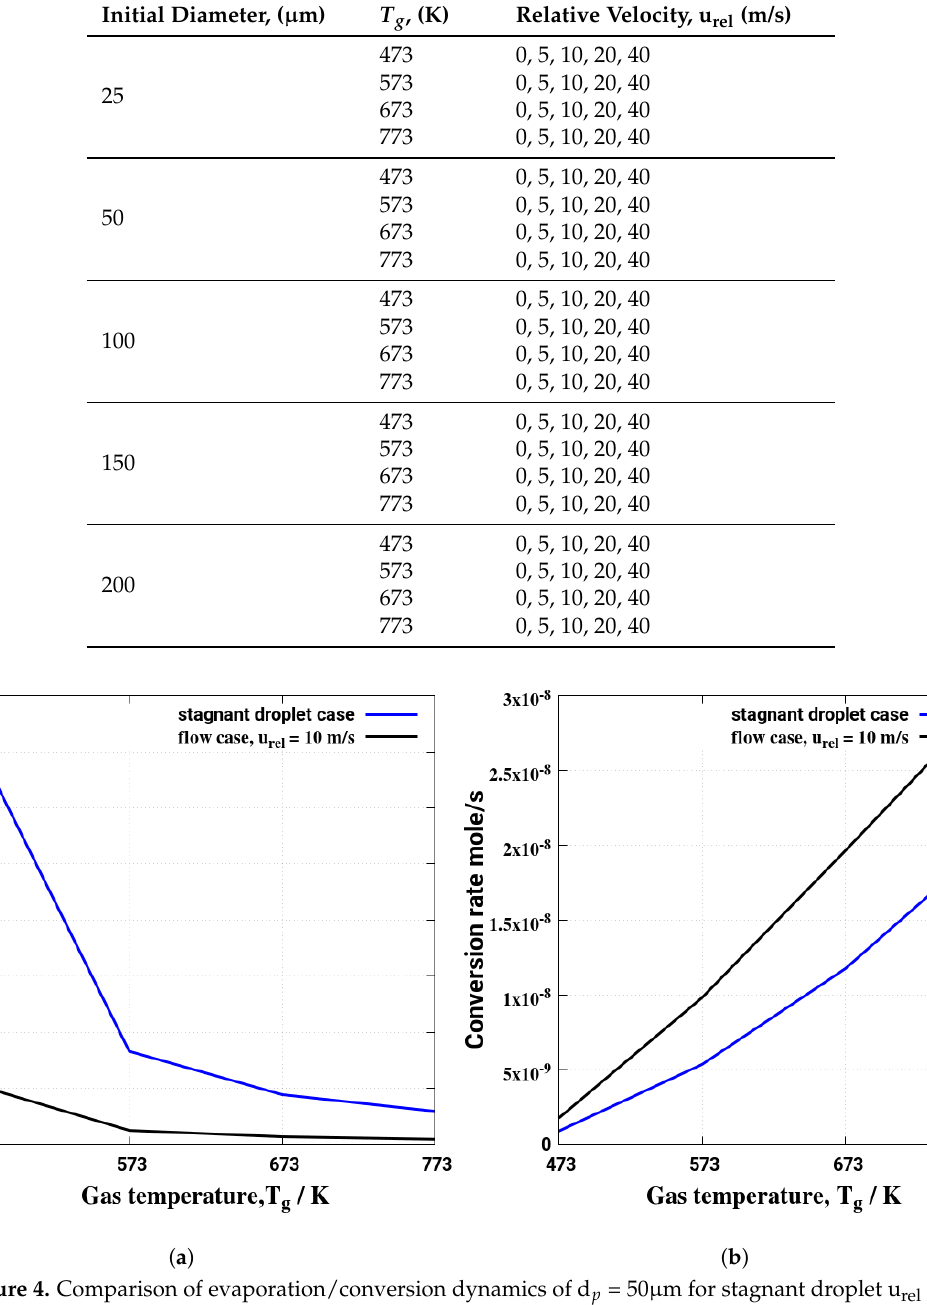
Table 3. Operating parameters for droplet life parametric study.